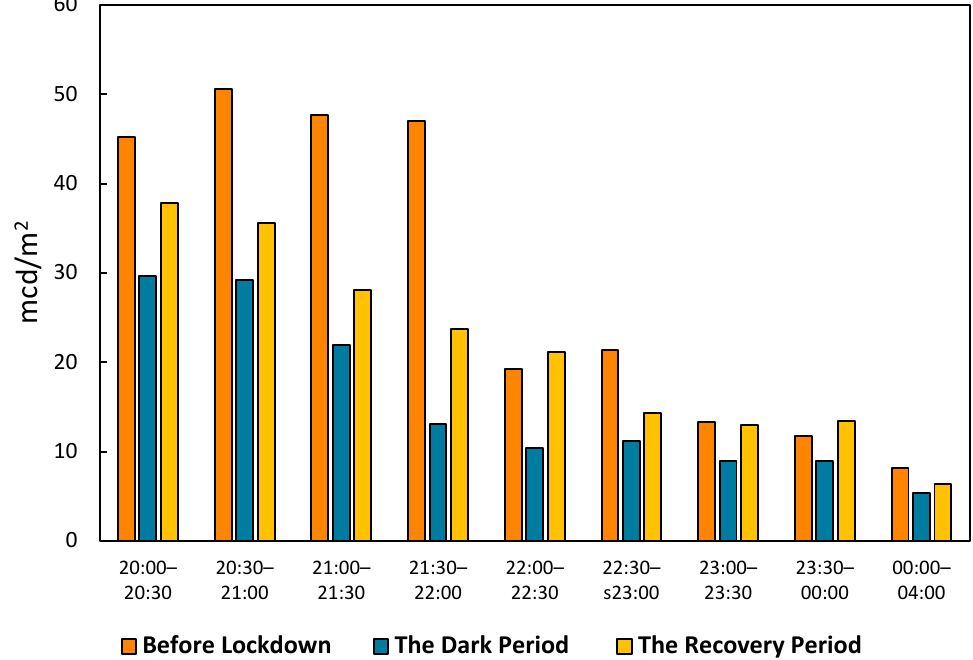
Figure 8. The average zenithal sky brightness (ZSB) at various time intervals during the three peri- ods. Table 3. The daily ZSB values at all time intervals from 1 November 2019 to 11 April 2020. Note that the dates of ZSB values after midnight are advanced by one day to maintain temporal consistency, which means the ZSB value at the 0:00–4:00 time interval of 1 November in Table 3 was recorded at the dawn of 2 November.